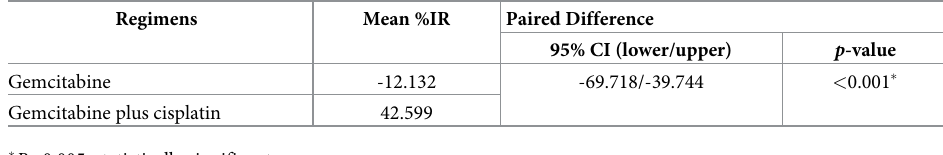
Table 4. Comparison the %IR between gemcitabine and gemcitabine plus